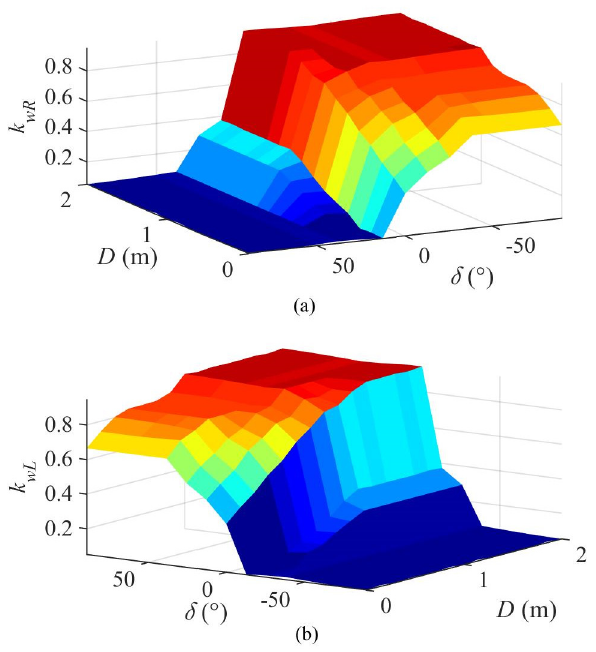
Figure 7. Fuzzy controller surfaces with 49 inference rules for multiples of maximum speed of: ( a ) right engine k wR ; ( b ) left engine k wL .